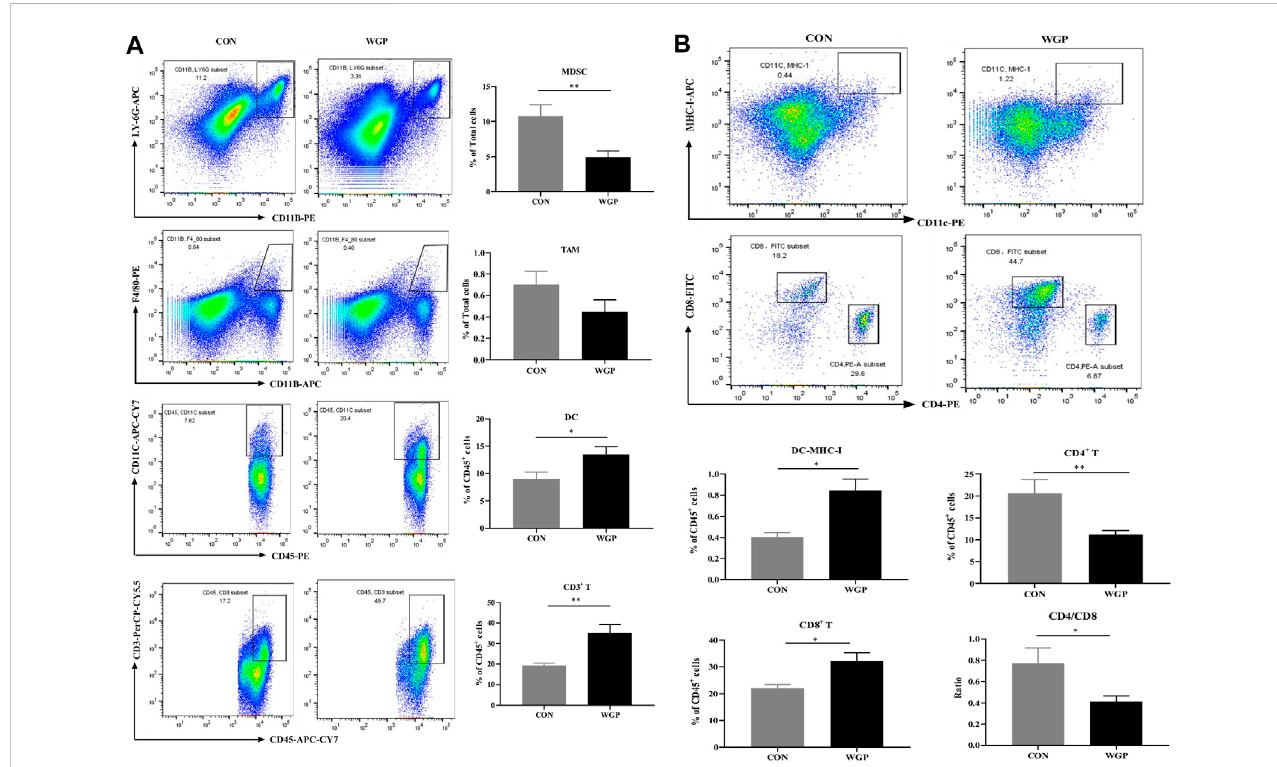
FIGURE 2 WGP alters immune cell in fi ltration in CAC (A) At Day 84, the representative staining, percentage of MDSCs (CD11b + LY-6G + ), macrophages (CD11b + F4/ 80 + )gatedintotalcells,dendriticcells(DCs)(CD45 + CD11c + ),andTcells(CD45 + CD3 + )gatedinCD45 + cellsofthetumorweredeterminedby fl owcytometry. (B) MHC-I + DCsgatedinDCs,CD8 + TcellsandCD4 + TcellsgatedinCD3 + Tcellsweredeterminedby fl owcytometry.Numbersadjacenttotheoutlinedareas indicate the percentage of the gated population in each group ( n = 5 – 6). * p < .05, ** p < .01 vs. CON by unpaired Student ’ s